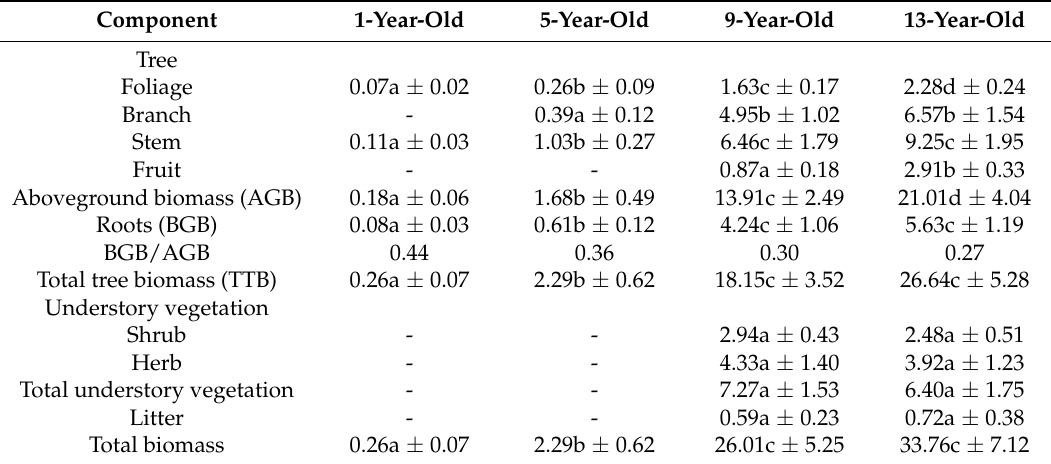
Table 2. Biomass (Mg ha − 1 ) in trees, understory vegetation, and litter in four age classes of J. regia plantations ( n = 3).